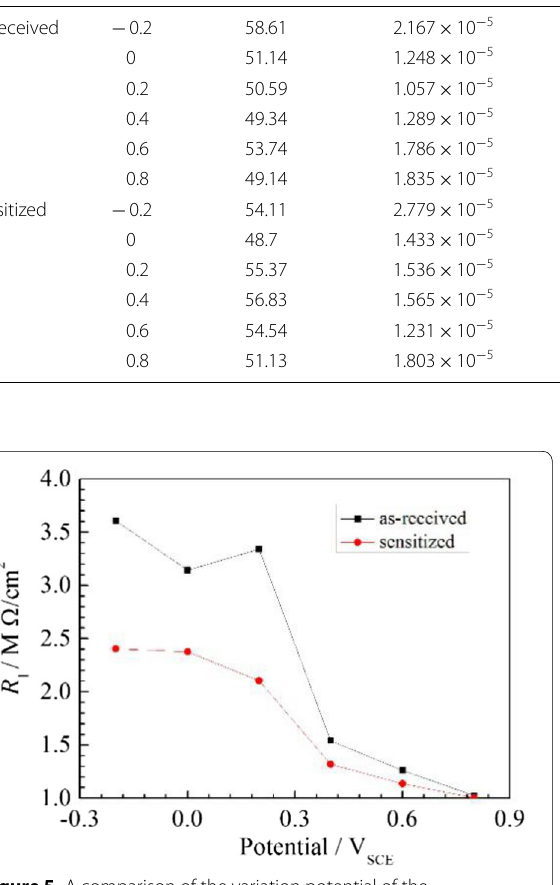
Table 2 Equivalent circuit for fitting parameters of 304 stainless steel in borate buffer solution Potential E (V)